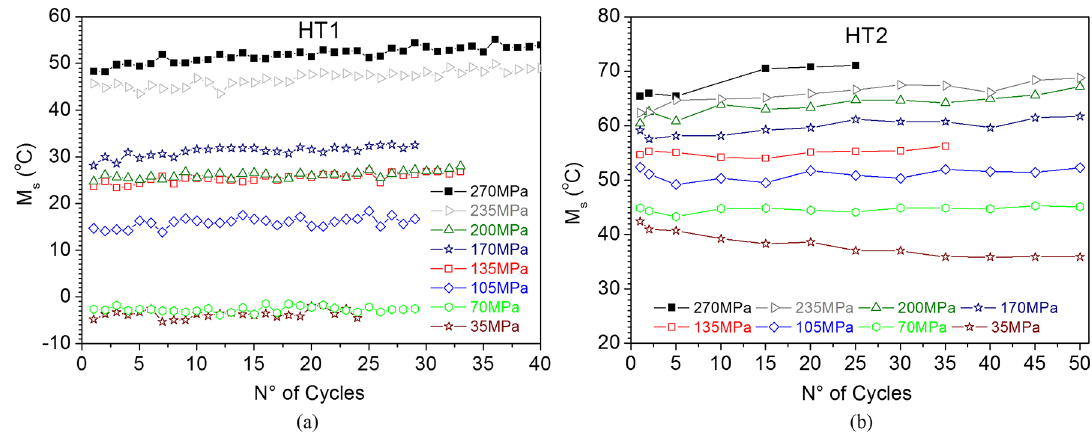
Figure 7. Evolutions of the Ms versus number cycles for 35, 70, 105, 135, 170, 200, 235 and 270 MPa applied stresses: (a) HT1 and (b)